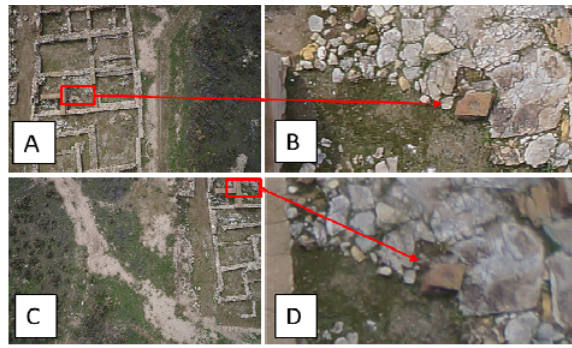
Figure 7. Sony NEX 5N images (A, C) acquired in stop-mode with the UAS hovering above the terrain at 20 m height (village sector at Puente Tablas Oppidum).